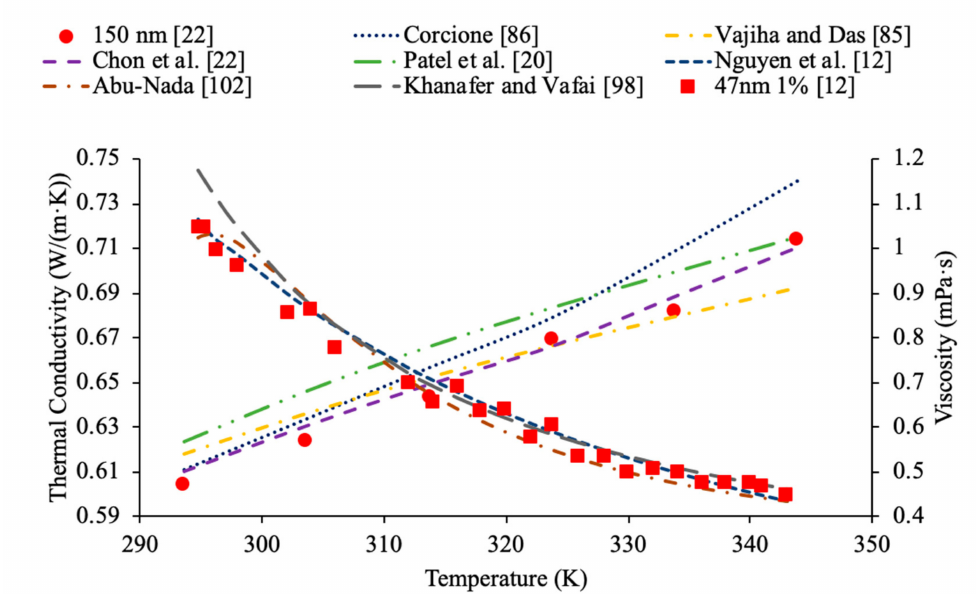
Figure 41. Thermal conductivity (increasing with temperature) and viscosity (decreasing with temperature) for 150 and 47 nm Al 2 O 3 –water nanofluids [12,24] in comparison to various theoretical models